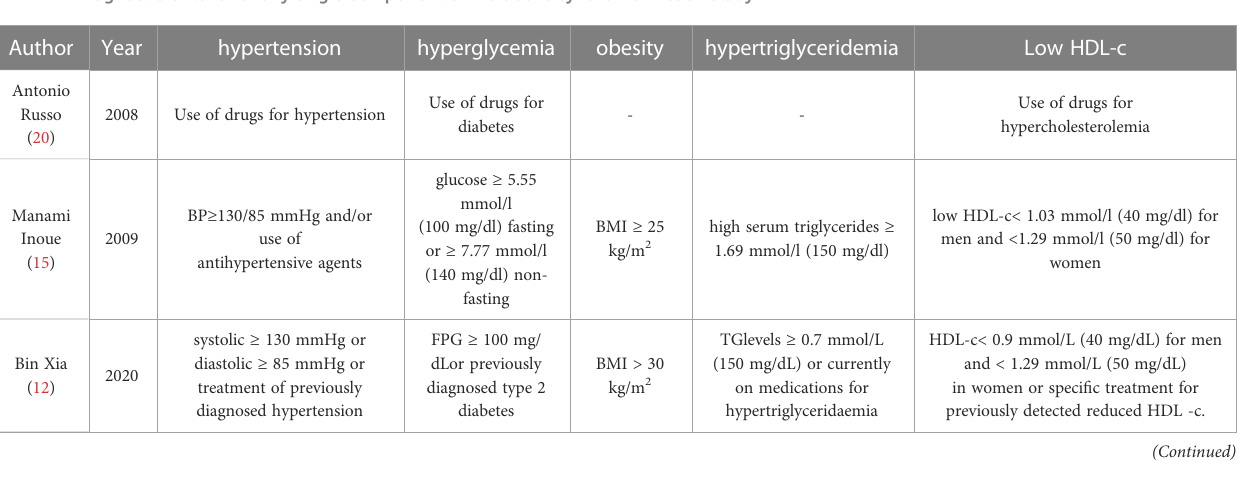
TABLE 2 Diagnostic criteria for any single component of metabolic syndrome in each